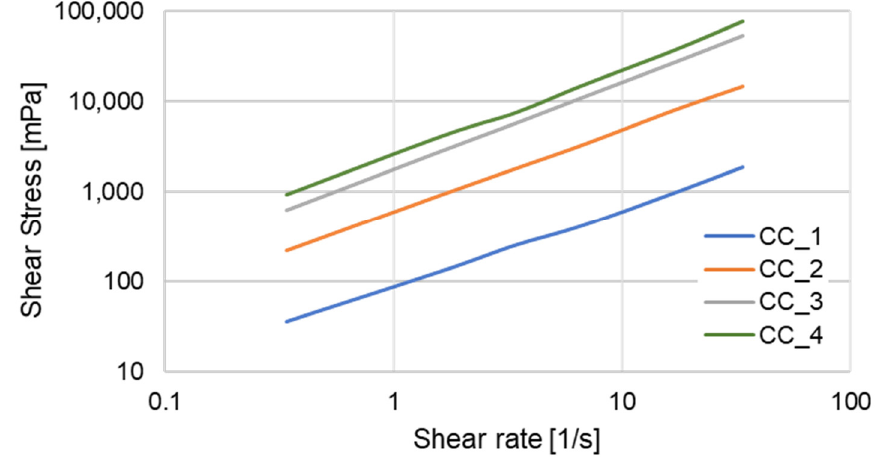
Figure 11. The flow behavior of shower gels a function of shear rate.